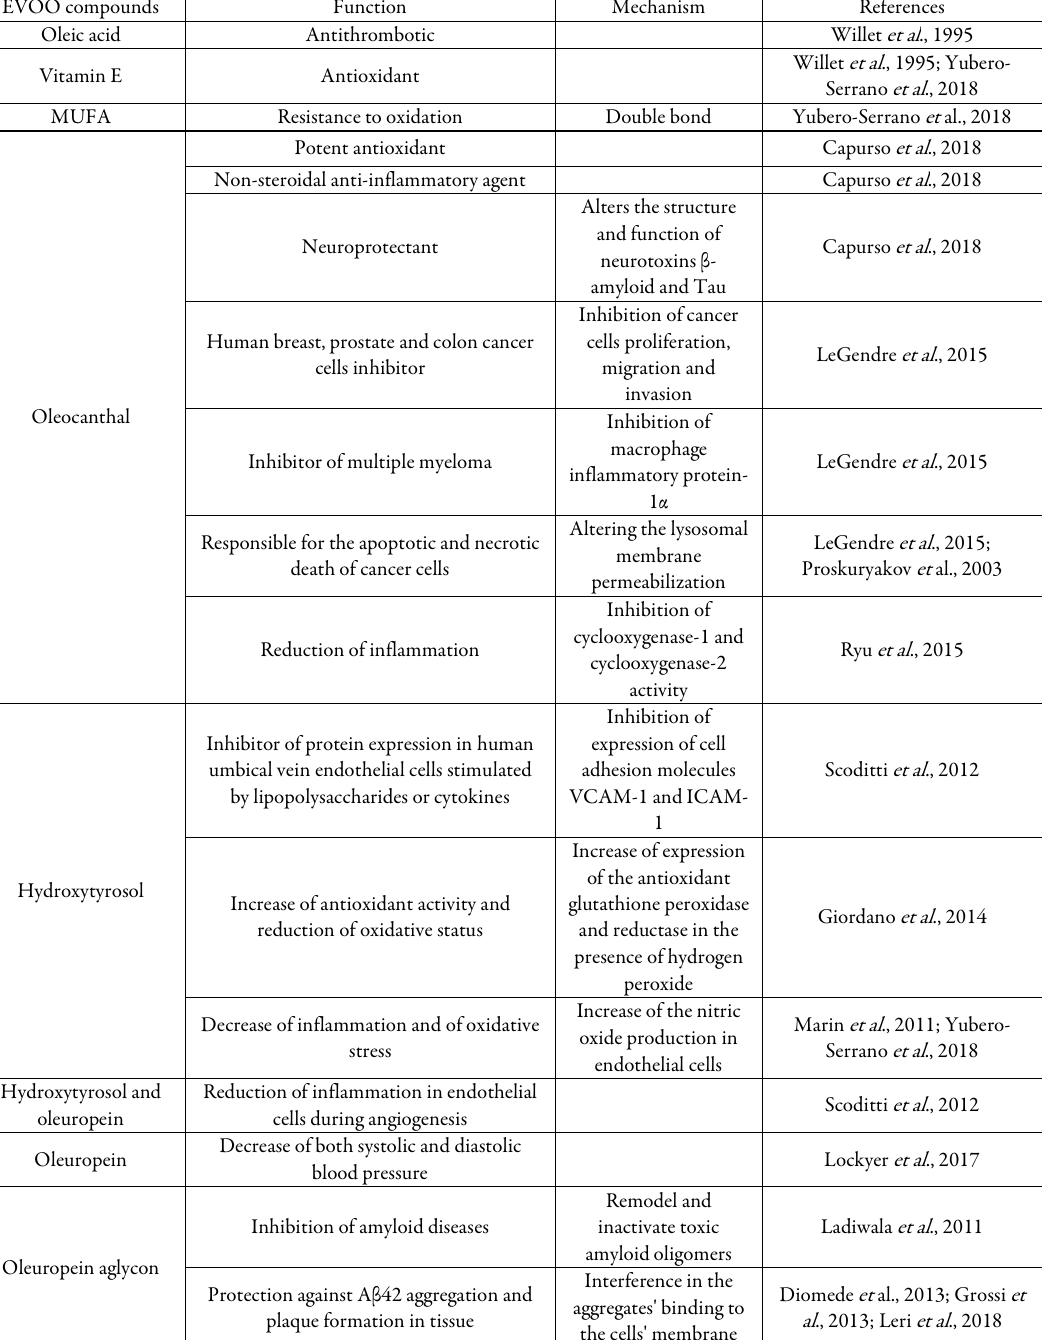
Table 2. EVOO compounds and their beneficial function EVOO